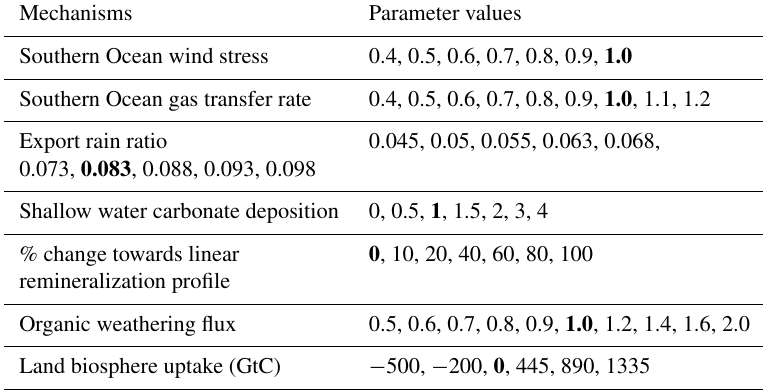
Table 2. Overview of mechanisms and parameters considered in factorial sensitivity experiments. Bold entries mark the standard parameter values. Values represent the export rain ratio at LGM, the change in remineralization profile (see text) at LGM, the scaling applied to the standard shallow water carbonate deposition history, and the land carbon uptake over the deglacial in gigatons of carbon (GtC). In the case of SO wind stress, SO gas transfer rate, and the organic weathering flux, values represent the ratio of LGM to PI